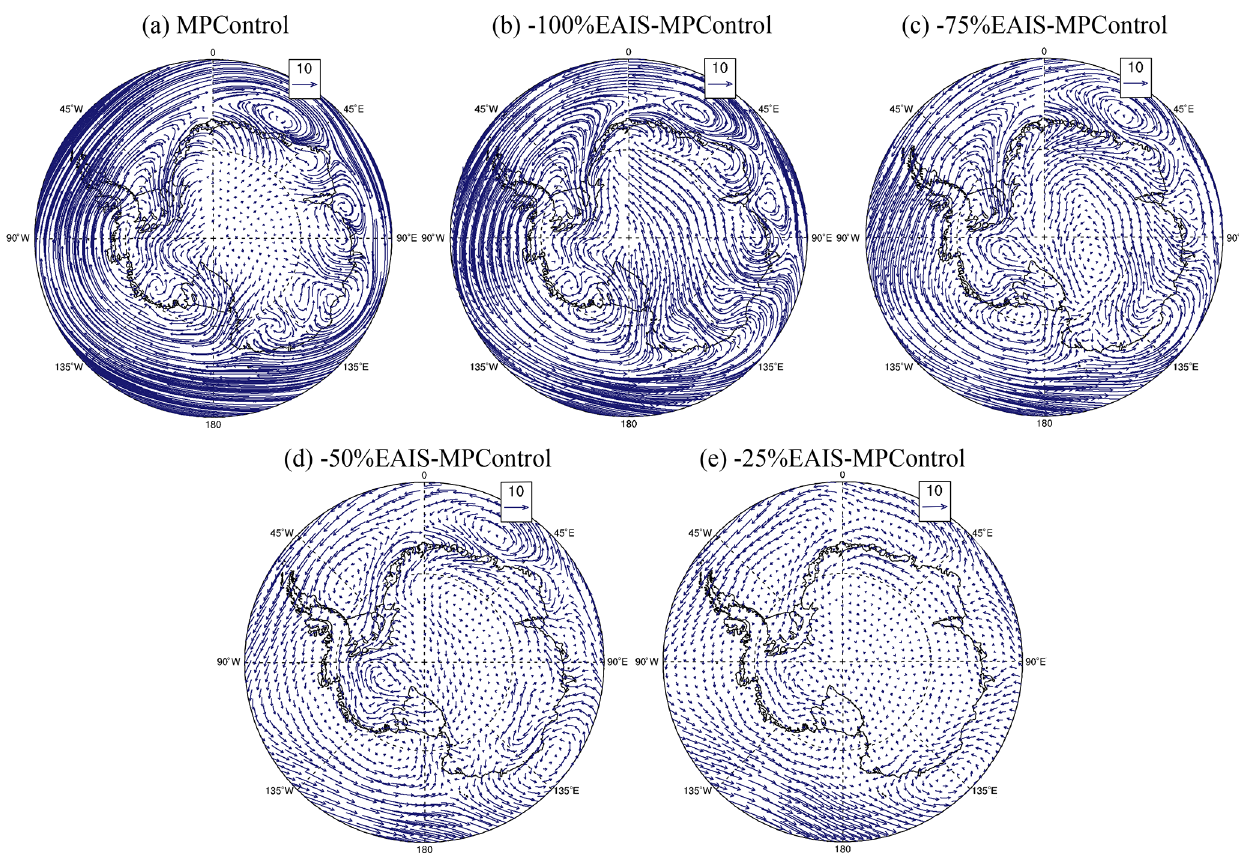
Figure 7. Vertically integrated water vapor flux over Antarctica (arrows; units: kgm − 1 s − 1 ) for (a) the MPControl, and the anomalies (arrows; units: kgm − 1 s − 1 ) for (b) the − 100%EAIS relative to the MPControl, (c) the − 75%EAIS relative to the MPControl, (d) the − 50%EAIS relative to the MPControl, and (e) the − 25%EAIS relative to the